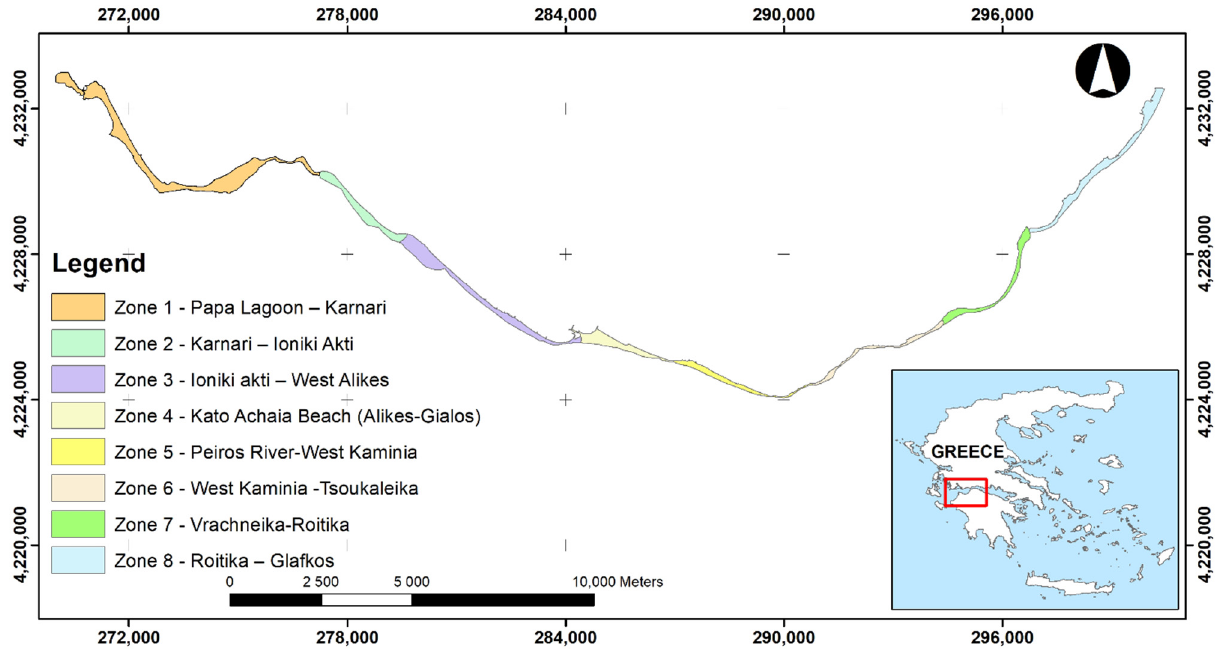
Figure 1. Map of the study area (use of the Hellenic Geodetic Reference System, 1987). For the assessment of vulnerability, the shoreline of the Gulf of Patras was divided into eight (8) zones and each zone in equal segments of 50 m (Figure 2).